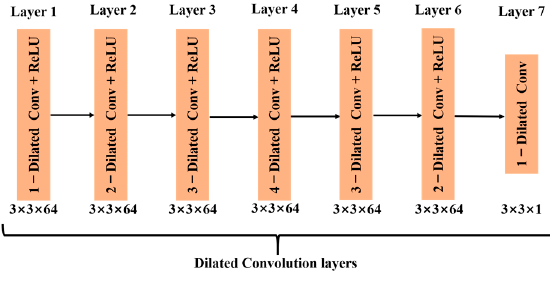
Figure 3. Dilated convolution in the proposed model.